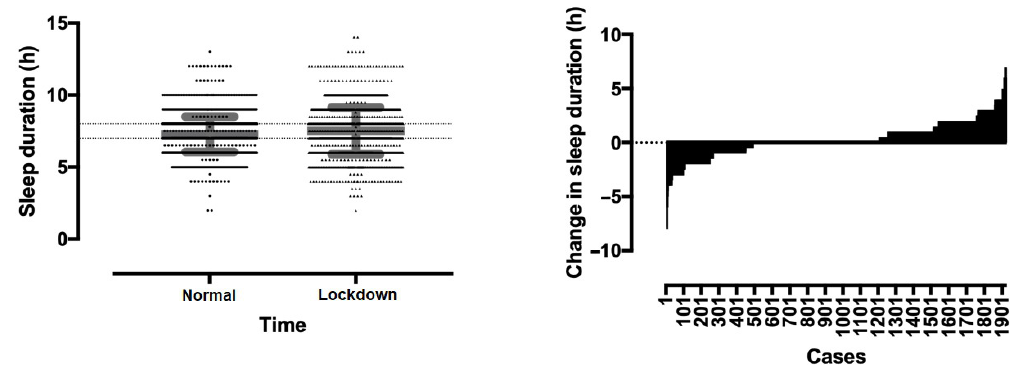
Figure 1. Distribution of sleep duration in normal and lockdown week ( left ) and change of sleep duration ( right ). On the left, the two parallel dashed lines show the range of 7–8 h sleep duration; error bars in grey show standard deviations; dots and horizontal lines show unique cases.